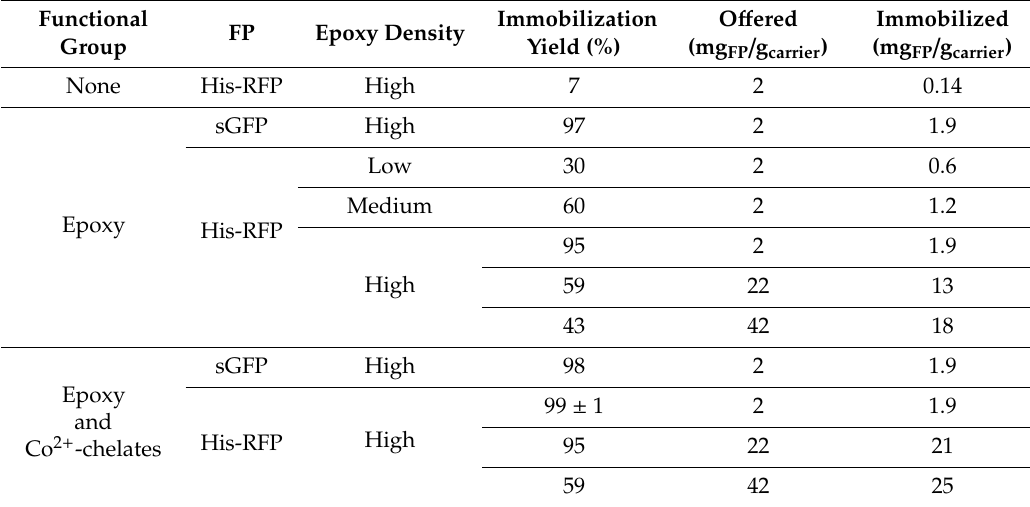
Table 1. Immobilization parameters of fluorescent proteins (FPs) immobilized on di ff erent activated supports. RFP: red fluorescent protein; sGFP: superfolder green fluorescent protein.